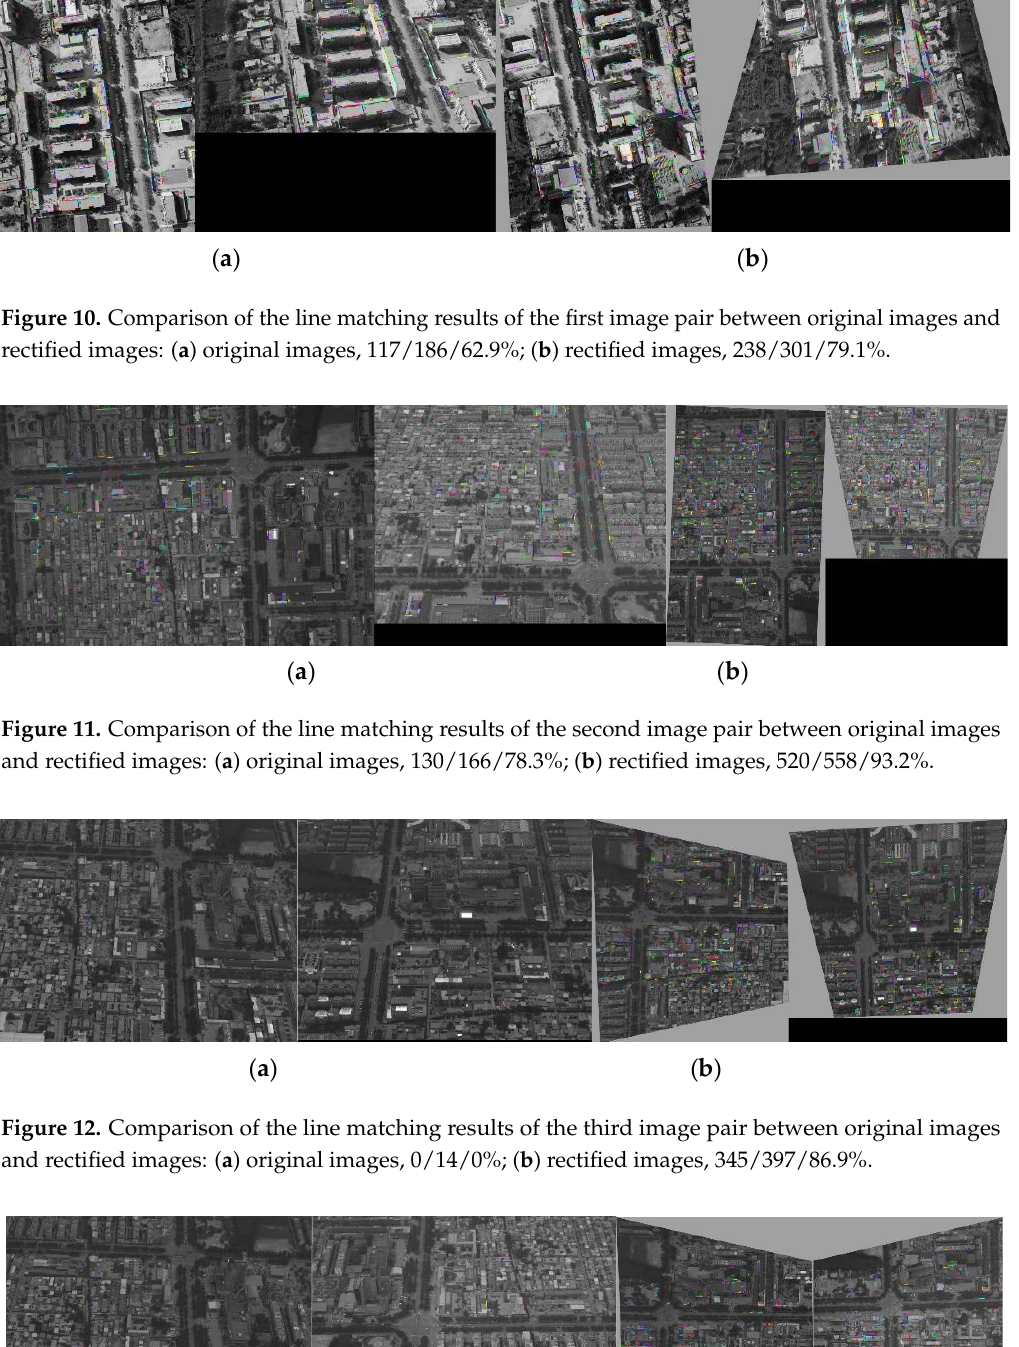
( d ) Image pair 4* Figure 8. Rectified images with perspective projection transformation. ( a ) Image pair 1*; ( b ) Image pair 2*; ( c ) Image pair 3*; ( d ) Image pair 4*. The red rectangle indicates a rectanglar building and the red circle indicates a round object, respectively, on the rectified images. From the above rectified images, it can be seen that the geographic orientation of every two images in each rectified image pair is the same; that is to say, perspective projections unify the images into the geodetic coordinate system. As a whole, the effective contents of the original images changed into trapezoids in rectified images. Especially for several side-looking images, the perspective distortion effects are large and the trapezoidal effects are obvious. It can also be seen that scenes close to cameras are compressed. The effective contents of down-looking images are approximate parallelograms due to the small viewing angles. Paying attention to the local details, it is observed that the trapezoidal or parallelogram structure (represented by a red rectangle) in the original side- looking image (image pair 3 in Figure 7) becomes an approximate rectangle (Figure 9a) in the rectified image (image pair 3* in Figure 8), and the ellipse (represented by a red circle) becomes a nearly perfect circle (Figure 9b). ( b ) Figure 9. Partial perspective rectification: ( a ) a trapezoid becomes a rectangle after rectification; ( b ) an ellipse becomes a circle after rectification.